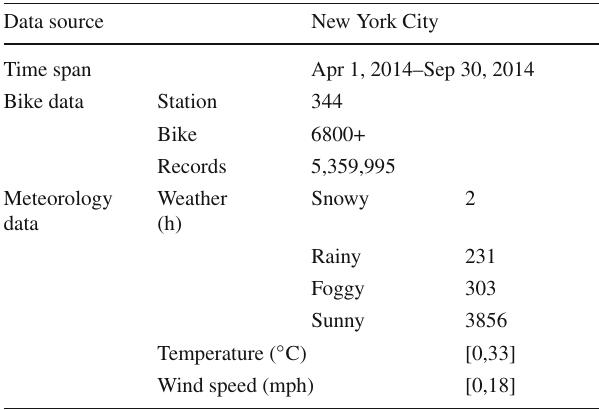
Table 1 Statistics of data sets Data